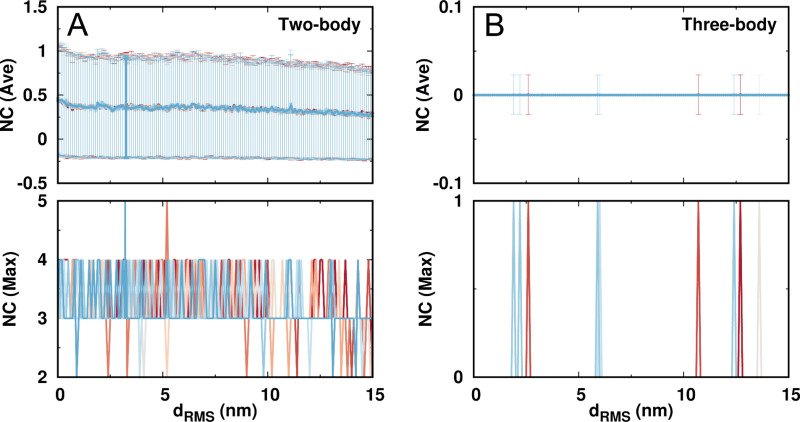
The number of contacts (NC) formed by the same charged beads in DPO4 during the DNA binding.The contacts are further classified into the (A) two-body and (B) three-body types. A contact is considered to form when the two beads are within the range of 0.5 nm, which is the distance for the two oppositely charged beads having DH potential strength equal to the native contact strength (1.0). The two-body (pairwise) contacts can be formed with a relatively low chance indicated by both the average and maximum contact numbers. At the same time, DPO4 is almost devoid of the three-body contacts formed by the same charged residues. This features no abnormally high number of same charges accumulated in a limited spatial space.